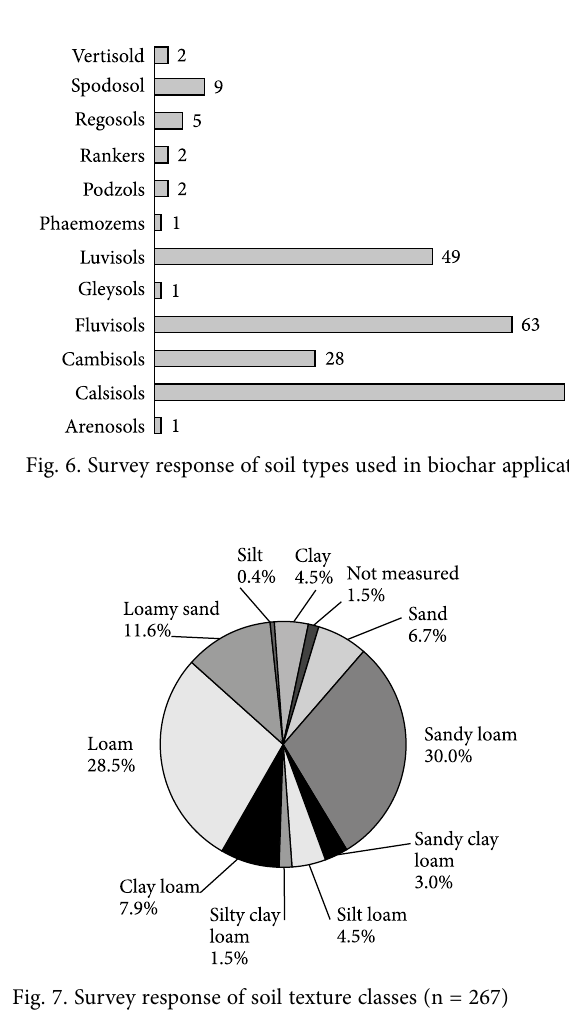
Fig. 5. Survey response of residence time in pyrolysis reactor (n = 203) application